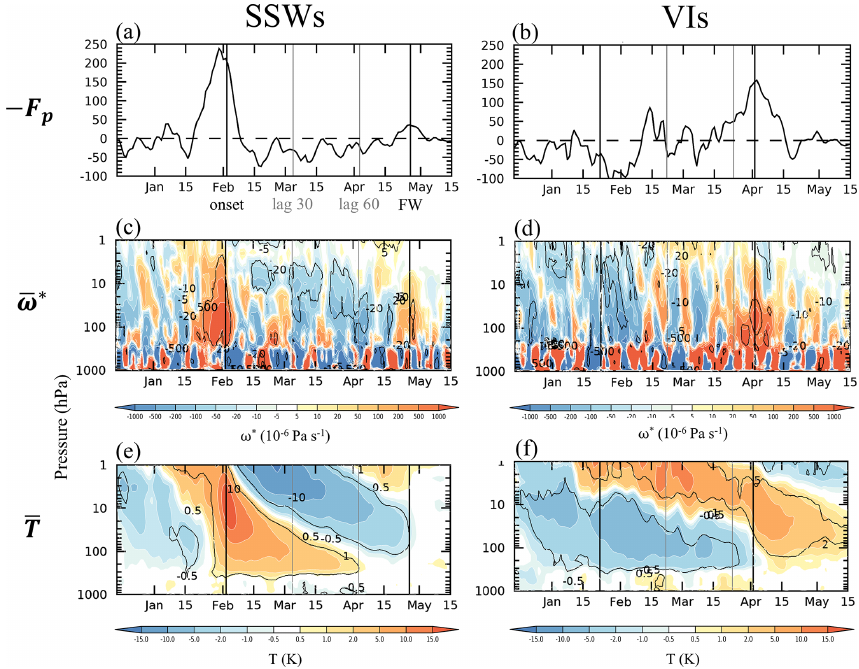
Figure 1. SSW (a, c, e) and VI (b, d, f) composites over the Arctic. Shown are (a–b) the time series of 10d smoothed vertical EP flux (10 4 kgms 4 ) averaged over 40–80 ◦ N at 100hPa, and time–height cross sections for (c–d) the vertical component of the residual circulation (10 − 6 Pas − 1 ; 65–85 ◦ N) and (e–f) temperature (K; 65–90 ◦ N). Contours represent the statistical significance at the 95%